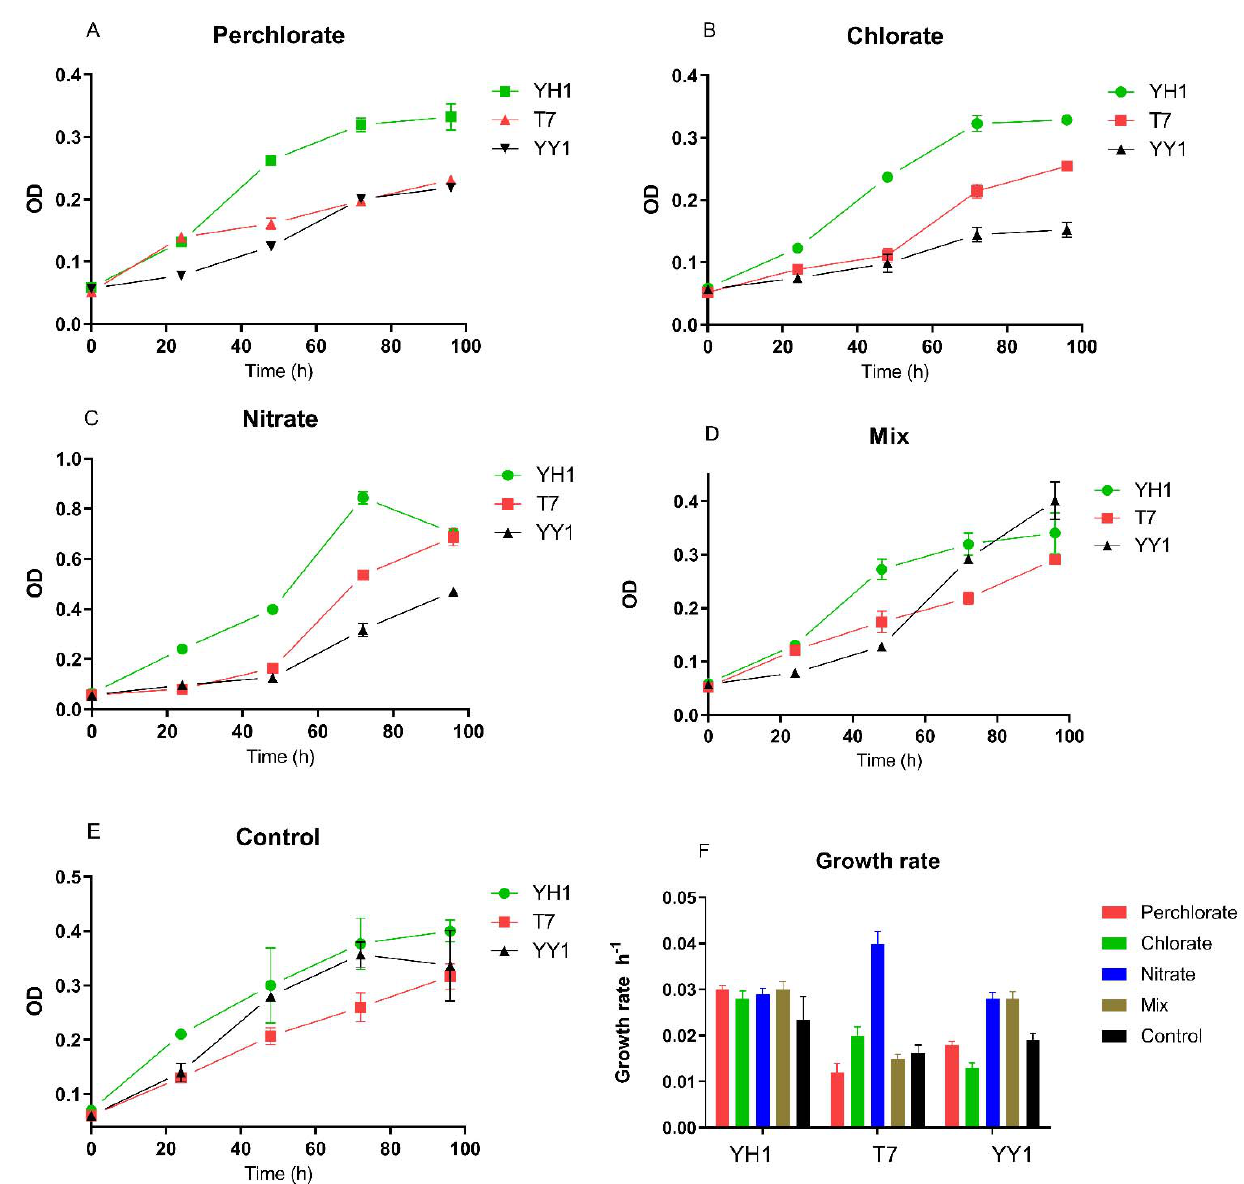
Figure 1. Effect of co-contaminants on the growth of three strains where RDX serves as the nitrogen source. ( A ) Perchlorate, ( B ) chlorate, ( C ) nitrate, ( D ) mix, ( E ) control, and ( F ) growth rate. The growth rate was derived from a nonlinear regression of the logarithmic growth phase. Triplicates were used in all treatments, and the results are average ± standard deviation.